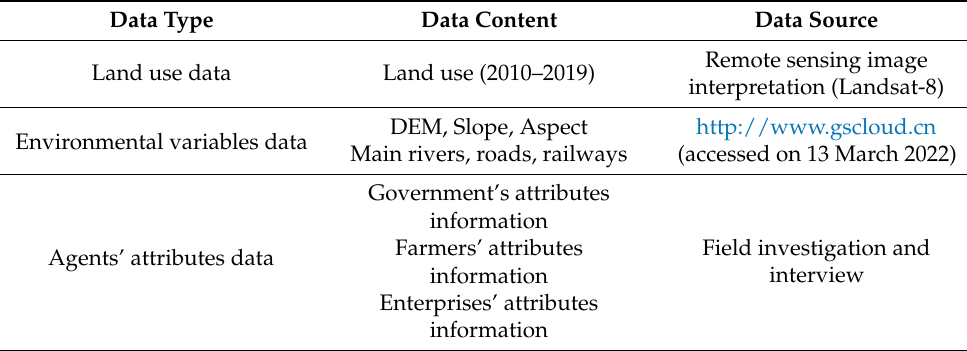
Table 1. Statistical table of research data in this